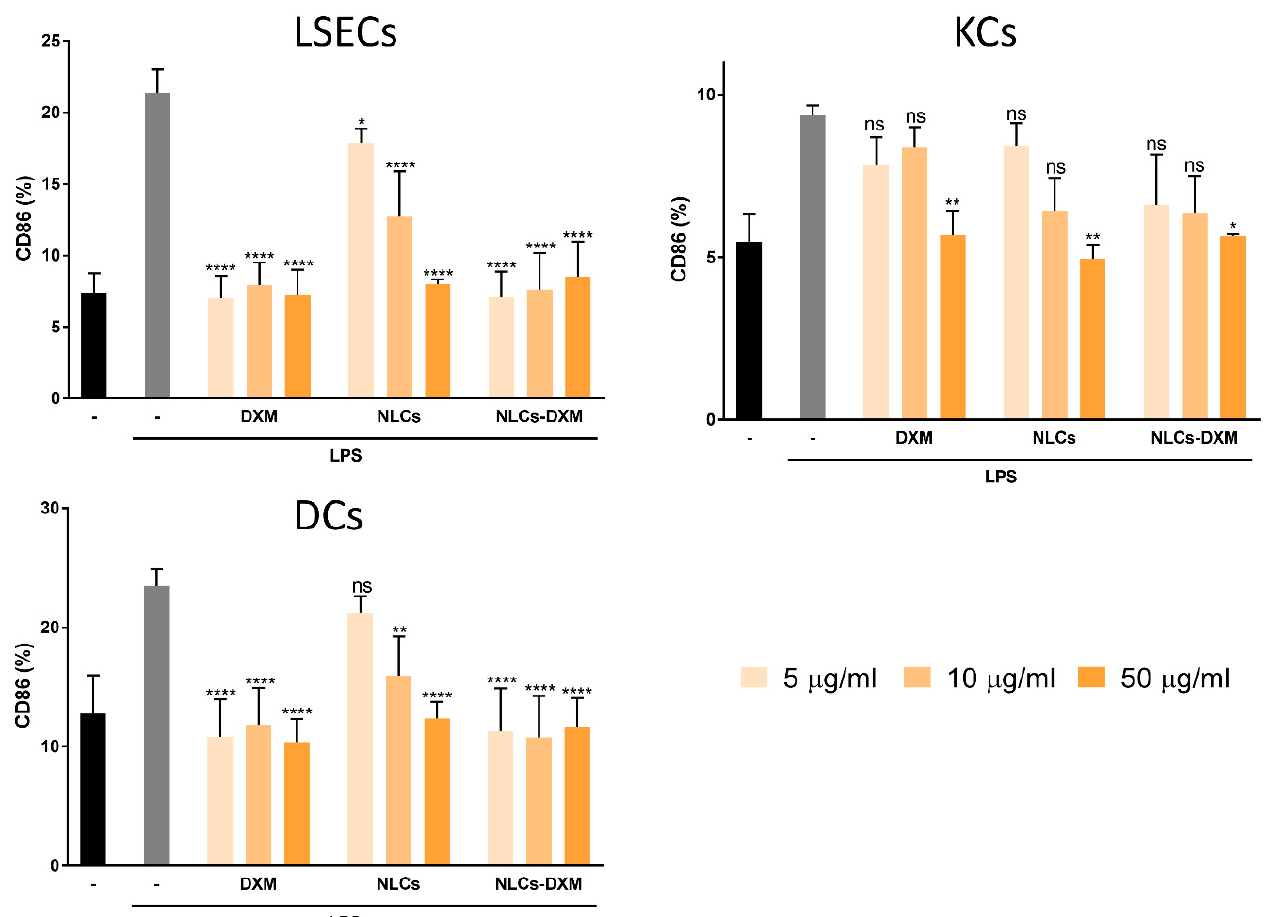
Figure 8. DXM released from NLCs counteracts induction of CD86 by LPS. NPC cultures were treated with soluble DXM, empty NLCs and DXM-loaded NLCs at three different concentrations (5, 10 and 50 µg/mL). LPS (100 ng/mL) was applied 45 min later. On the next day, NPC populations were phenotypically characterized: LSECs (CD45 + CD32b + ), KCs (CD45 + F4/80 + ) and DCs (CD45 + CD11c + ). The activation state of each cell type was studied by CD86 marker assessment. The gating strategy has been described [39]. Data represents the mean ± SEM obtained in 3 independent experiments. Significantly different from positive control (LPS only): no significant difference (ns); * p < 0.05; ** p < 0.01; **** p < 0.0001 (one-way ANOVA, Dunnett’s multiple comparisons test).